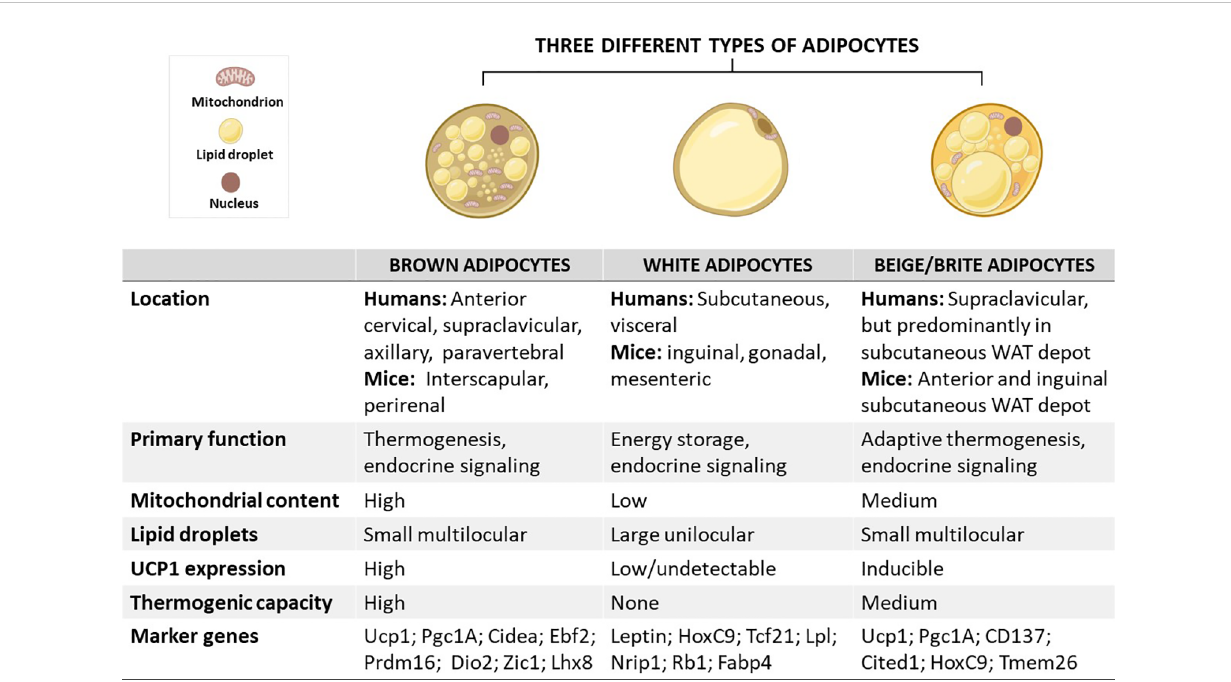
FIGURE 1 Schematic overview showing the characteristics of brown, white, and beige/brite adipocytes, including their localization, morphology, physiological function, and marker genes. In brief, the anatomical location of these adipocytes differs, except for white and beige adipocytes which are found within WAT depots. In terms of morphology and function, brown adipocytes are comprised of small multilocular lipid droplets, high mitochondrial content, and increased UCP1 expression, which can be also induced in beige adipocytes to promote thermogenesis and enhance energy expenditure, features that are important for the treatment of obesity. In sharp contrast, white adipocytes have fewer mitochondria and large unilocular lipid droplets to facilitate the storage of energy in a form of fats. Of note, these adipocytes have similar and distinct marker genes which could play an important role in tracking metabolic complications linked with obesity. Cidea, cell death-inducing DNA fragmentation factor-like effector A; CD137, tumour necrosis factor receptor superfamily, member 9; Dio2, Iodothyronine deiodinase 2; Lhx8, LIM homeobox protein 8; Pgc1A, peroxisome proliferator-activated receptor coactivator 1 alpha; Prdm16, PR domain-containing 16; Tcf21, Transcription factor 21; TMEM26, transmembrane protein 26; UCP1, uncoupling protein 1; WAT, white adipose tissue; Rb1, RB transcriptional corepressor 1; Zic1, zinc fi nger protein of the